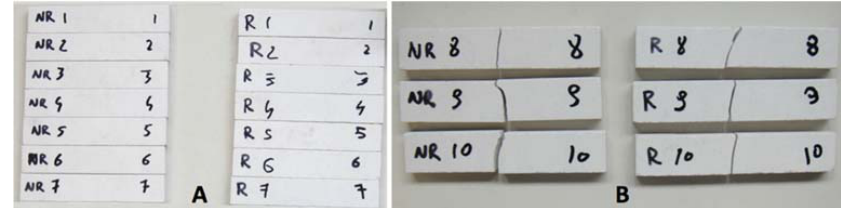
Figure 7. Annealed (R) and not annealed (NR) gres specimens before ( A ) and after ( B ) flexural tests.